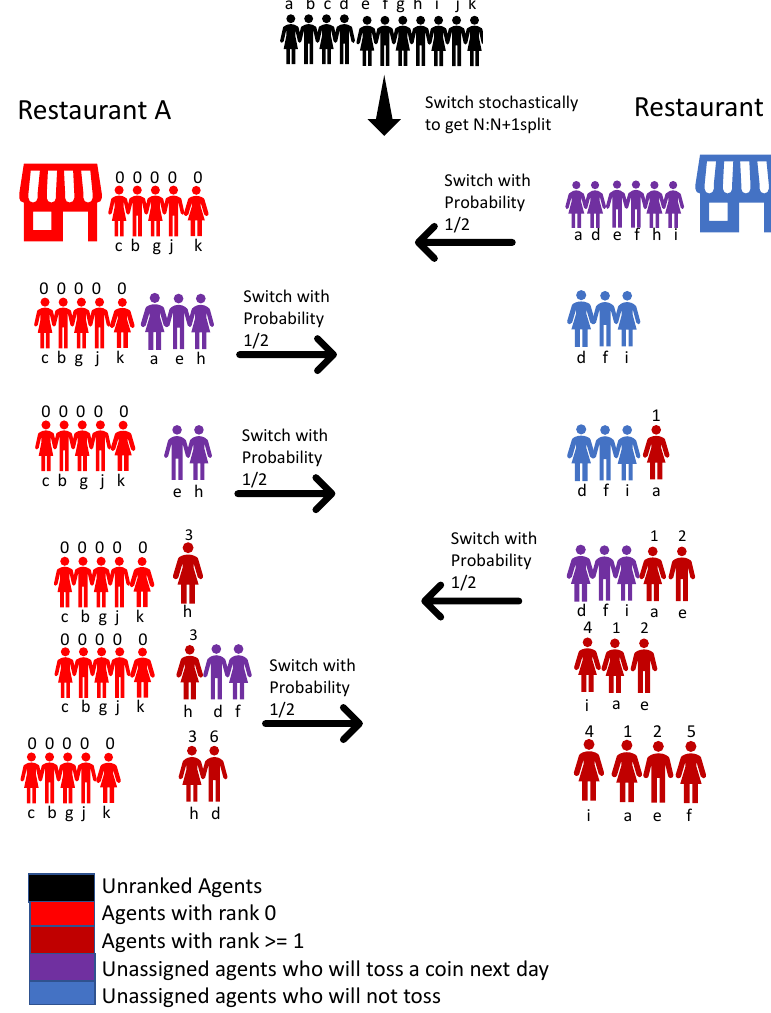
Figure 1. Ranking of N = 11 agents using the proposed algorithm. The numerals above the agents indicates their assigned